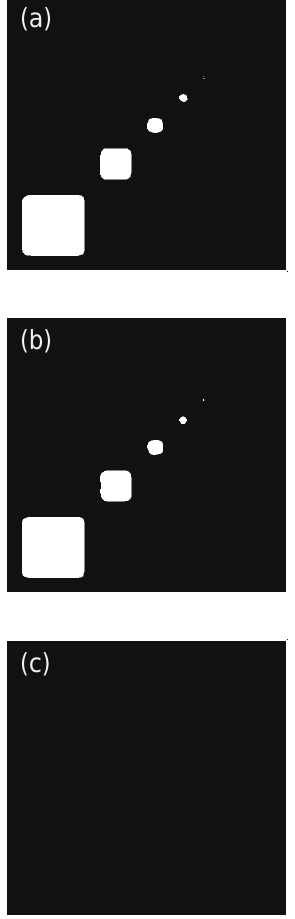
Figure 6. Cloud mask without applying noise reduction and central- pixel weighting. (a) , (b) and (c) are for the targets with strong, mod- erate and weak SNR, respectively, from Fig. 4a1, a2 and